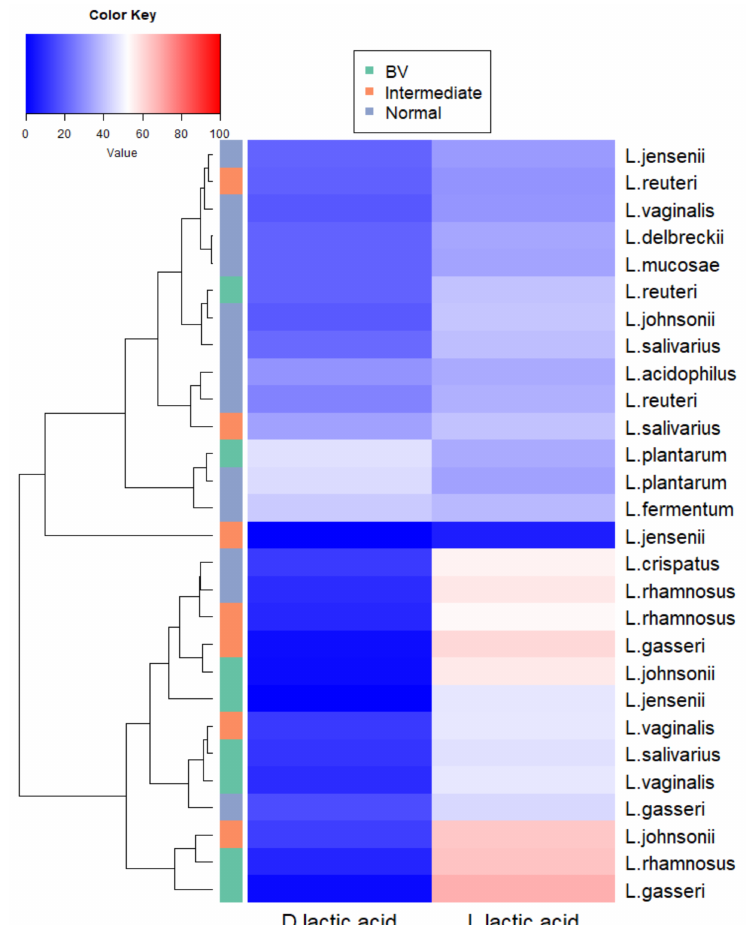
Figure 8. Heatmap of concentrations of lactic acid produced by di ff erent species of Lactobacillus present in normal, intermediate and asymptomatic BV microbiota. Mean values of d - and l -lactic acid amount in CFCs of each species from the three groups were used for hierarchical clustering. Lactobacillus species are shown on the right side and the microbiota from which they were isolated are represented on the left side of the heatmap. A color bar with scales is shown, indicating that dark red corresponds to the maximum value and dark blue to minimum